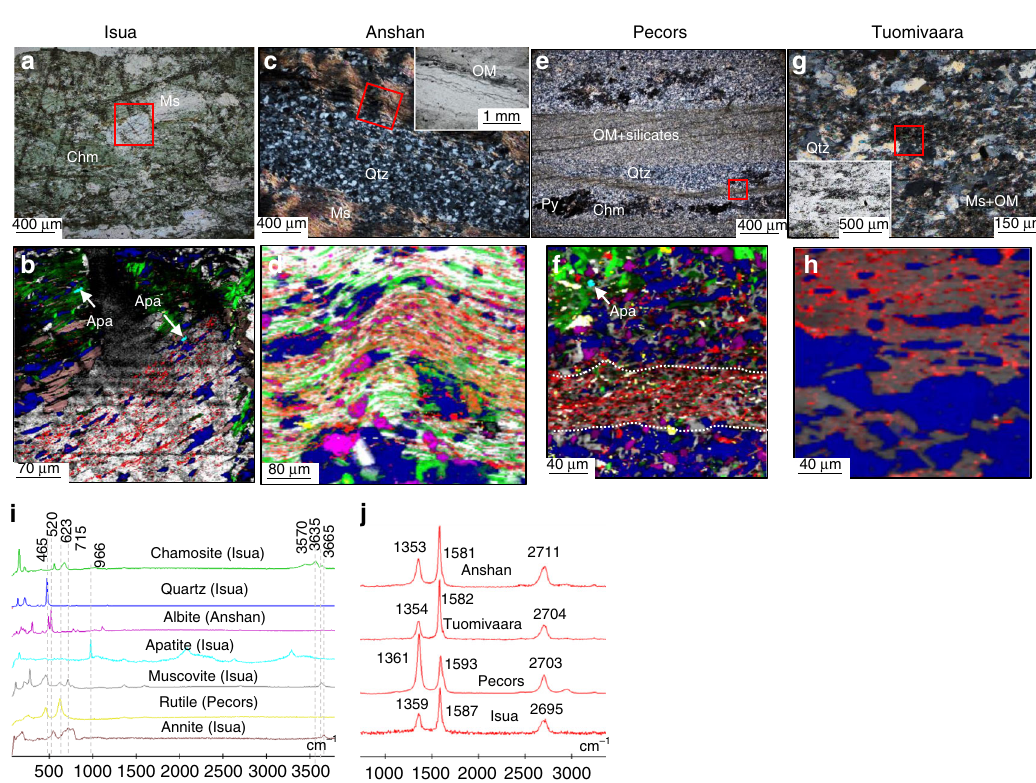
Fig. 2 Organic matter (OM) mineral assemblages in metapelites. a Transmitted light (TL) image of muscovite in the Isua metapelite, exhibiting parallel- aligned graphite inclusions. b Raman image of the boxed area in A, showing the concentration of graphite in muscovite. c Cross-polar image muscovite layers in the Anshan metapelite, inset is a TL image of the same area showing black particles of graphite in muscovite layers. d Raman image of the boxed area in C, showing graphite within muscovite and chamosite layers with dispersed grains of albite. e Cross-polar image of OM and silicate layers in the Pecors metapelite, with sulphide-chamosite clusters. f Raman image of the boxed area in E, showing the concentration of OM with muscovite in a matrix of quartz and albite. g CP image of muscovite in quartz from the Tuomivaara metapelite, inset is of the same image in TL, dark particles are graphite. h Raman image of the boxed area in G, showing graphite within muscovite. i Representative Raman spectra for this fi gure (Sample names refer to where spectra taken from). j Raman spectra for organic matter in the metapelites of this fi